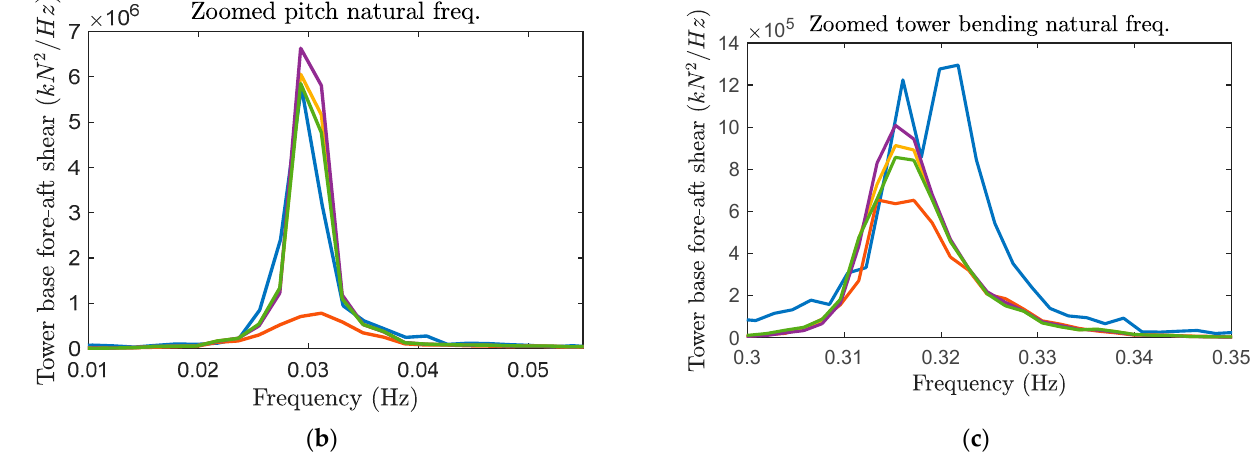
Figure 7. LC3.3 tower base fore-aft shear force power spectral density (PSD): ( a ) full spectrum view; ( b ) spectrum zoomed near pitch natural frequency; ( c ) spectrum zoomed near tower bending natural frequency.